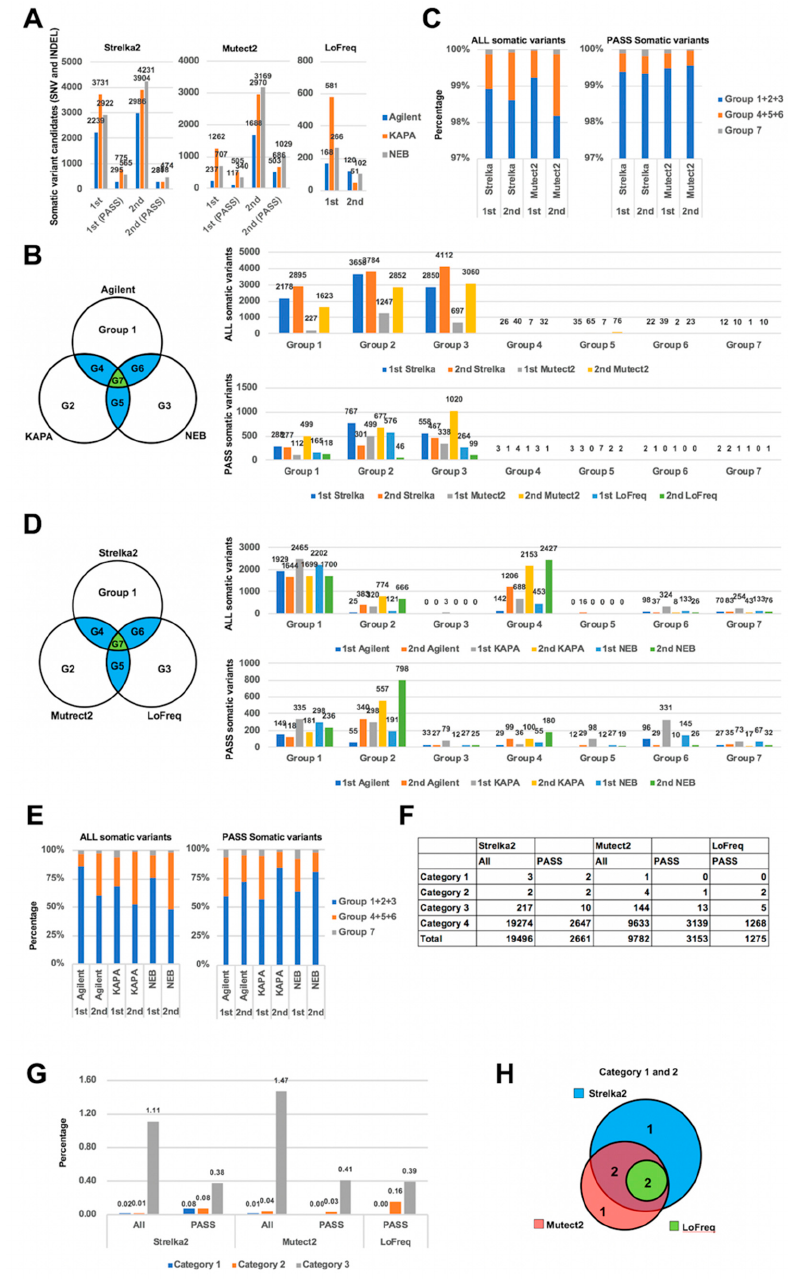
Figure 3. Comparison of the somatic variant callers in dual deep sequencing. ( A ) The number of somatic variants called by each somatic variant caller. ( B , D ) Venn diagrams showing the groups of the detected somatic variants using three different DNA polymerases with each of the somatic variant callers ( B ) and the three somatic variant callers with each of the DNA polymerases ( D ). The number of all somatic variants (top) and passed somatic variants (bottom) in each group. ( C ) The ratio of variant groups in Figure 3B, variants detected in only one polymerase (Group 1, 2, and 3), variants common to two polymerases (Group 4, 5, and 6) and variants common to all polymerases (Group 7), were plotted for each variant caller and each experiment. ( E ) Similarly, the ratio of variant groups by the number of variant callers detecting the same variant in Figure 3D were plotted for each polymerase and each experiment. ( F ) Classification of the variants into 4 categories. ( G ) The percentage of variants in category 1, 2, and 3. ( H ) Venn diagram showing the number of somatic variants that are detected in category 1 and